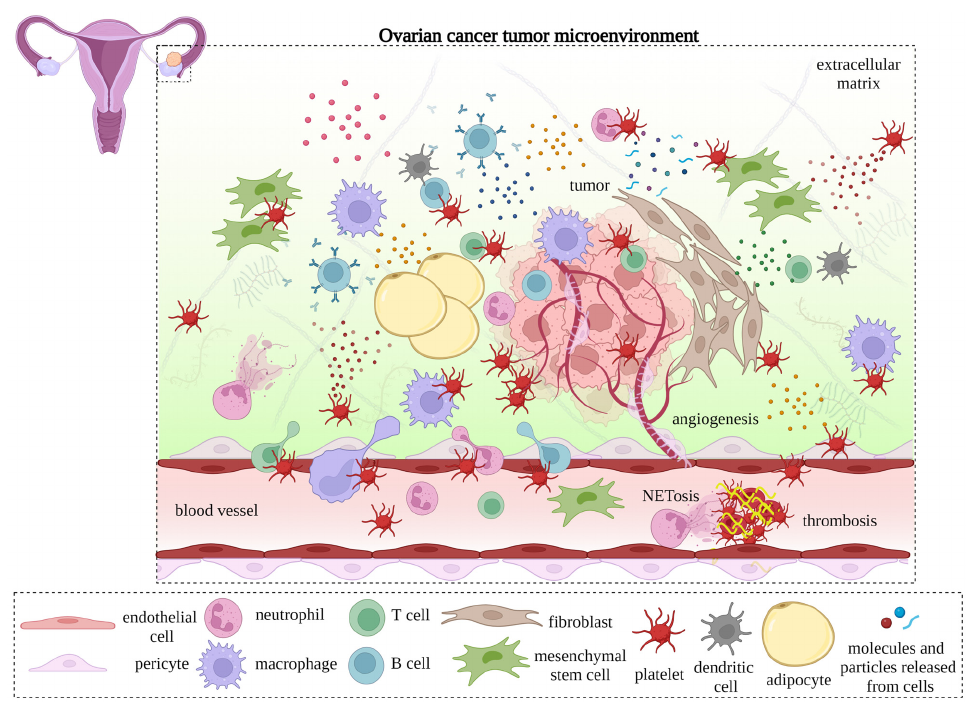
Figure 1. The tumor microenvironment (TME) of ovarian cancer. Tumor cell-induced activated platelets engage with endothelial cells, pericytes, mesenchymal stem cells (MSCs), cancer-associated fibroblasts (CAFs), adipocytes, immune cells, and extracellular matrix (ECM) elements through direct interaction or by releasing various modulatory factors and platelet microparticles. Platelets promote the extravasation, differentiation, and activation of these cells, which, in turn, contribute to the hyper-responsiveness of platelets and thrombosis in a positive feedback loop. Table 1. The major components reside on activated platelets or are released from platelet granules.